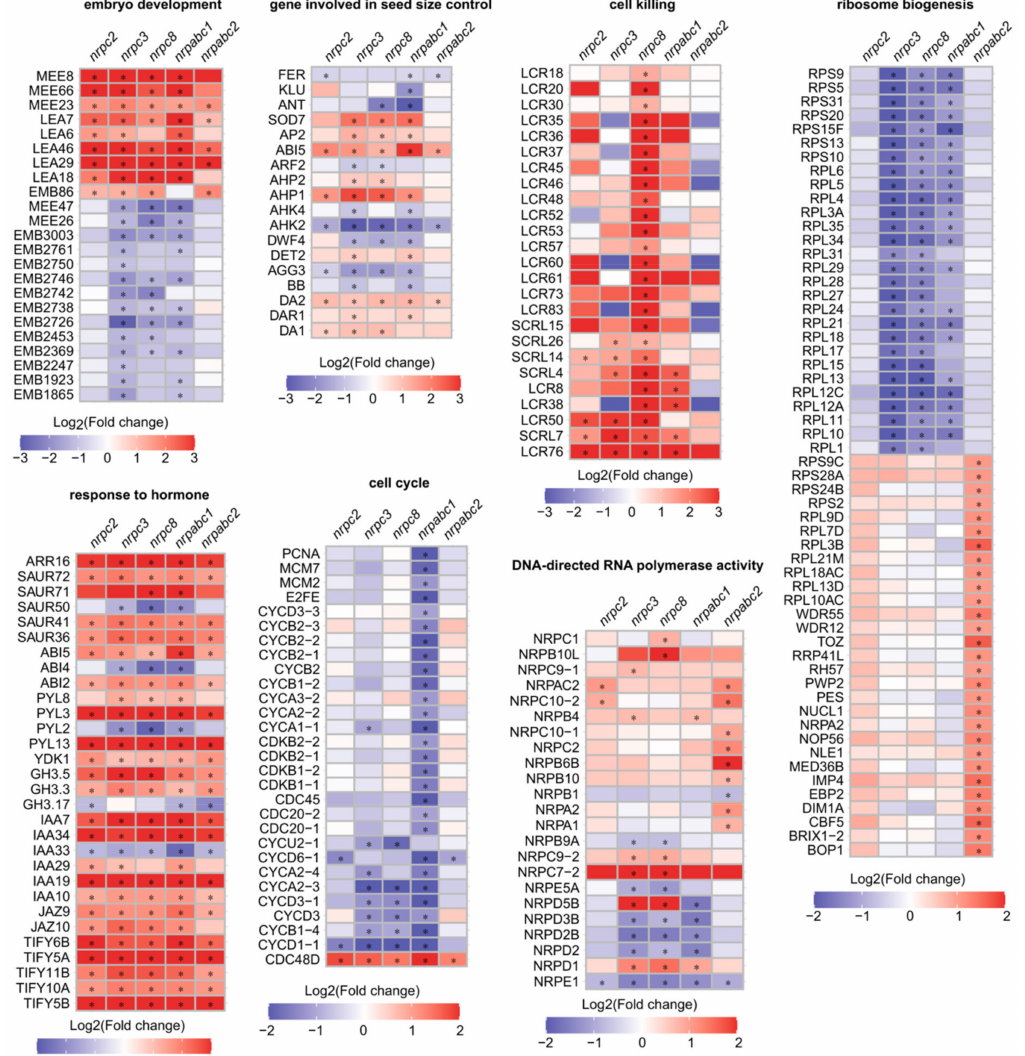
Figure 5. Heat maps of DEGs functioning in selected disrupted pathways (“*” p < 0.01, absolute value of log 2 (fold change) >